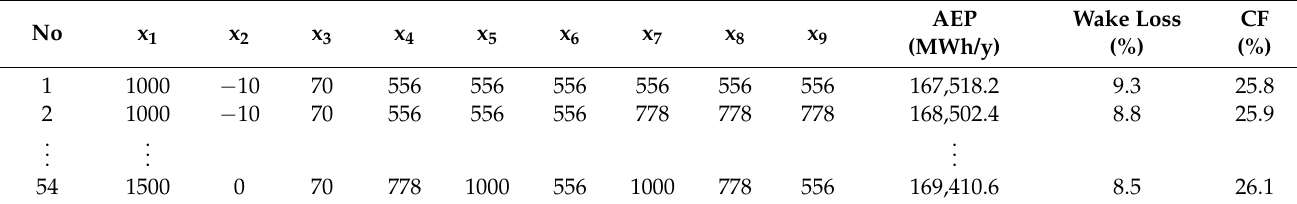
Figure 5. Design variables for offshore wind farm layout based on regular pattern (scenario 1). ( a ) Farm pattern, ( b ) Wind turbine generator column distance.